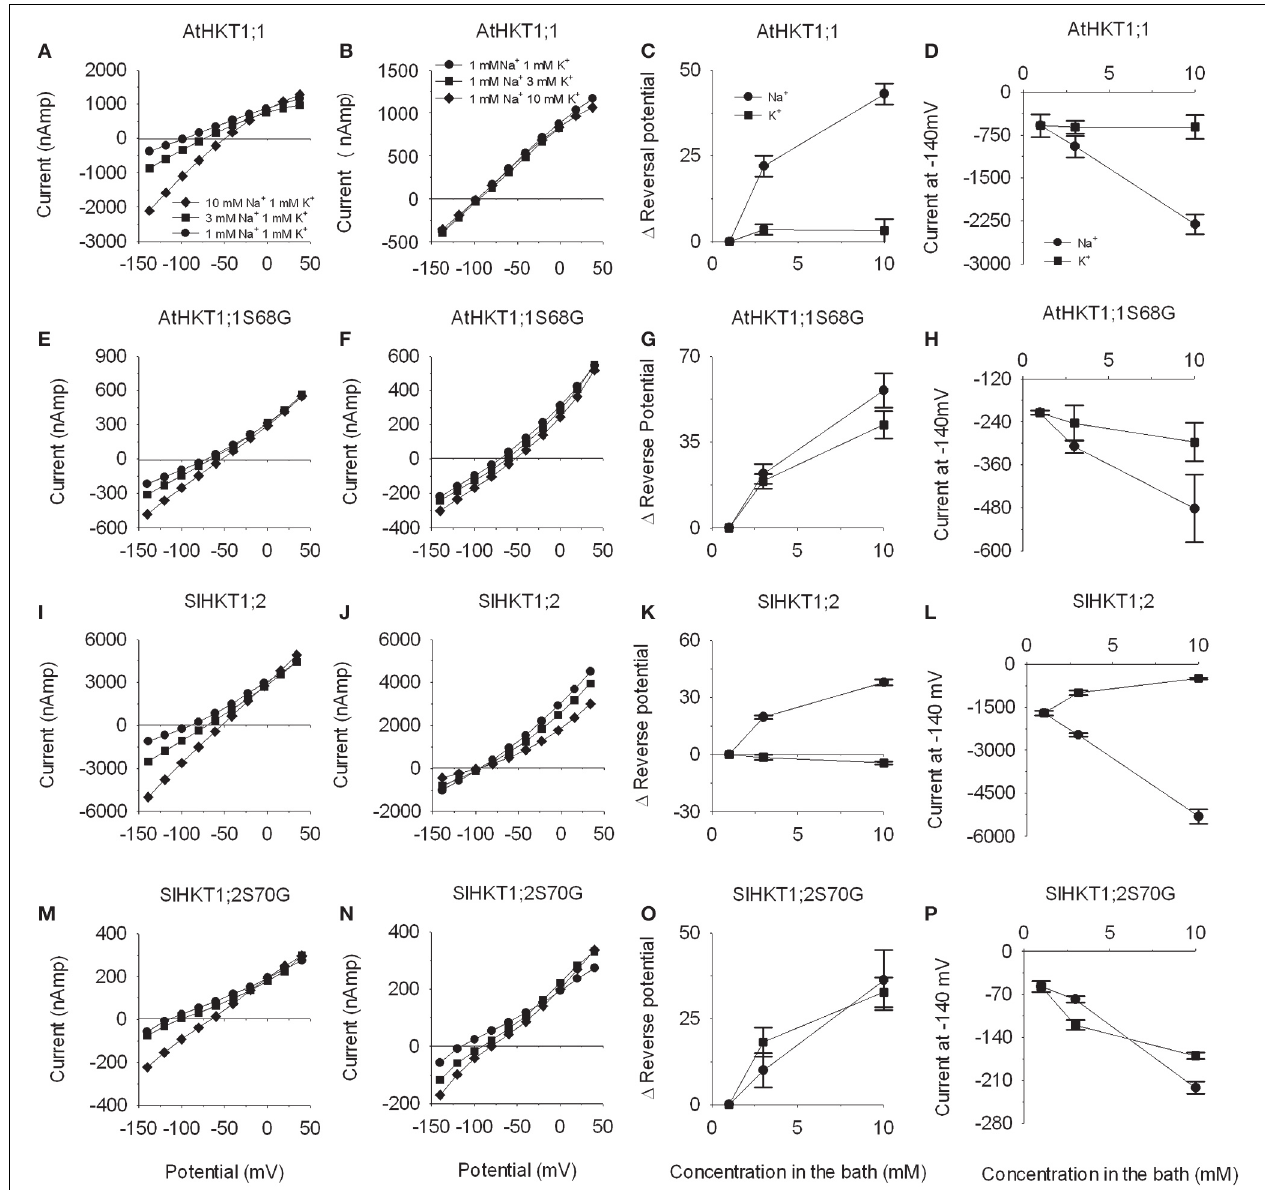
ion concentration. Only transporters where the S of the 1st pore domain was mutated to a G were permeable to K + as indicated by the large positive shifts in the reversal potential with increasing concentrations of K + in the bath; (D,H,L,P) Absolute currents as a function of ion concentration. Transporters where the S of the 1st pore domain was mutated to a G showed an increase in current with increasing K + concentration in the bath. Data are means ± SE ( n = 3, experiments done with at least two different oocyte